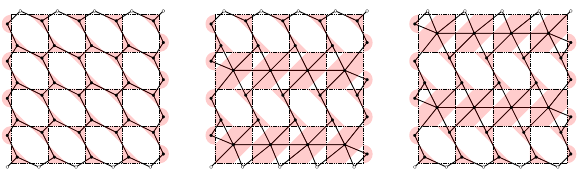
FIG. 21. Matching graphs ( X type) for the L ¼ 5 subsystem surface code with triangle operators fixed in all rows (left), odd rows (middle), and even rows (right). Filled and hollow circles correspond to stabilizers and boundary nodes,